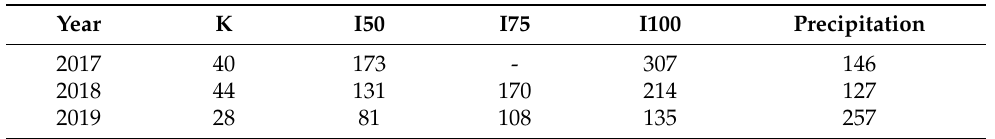
Table 4. Net irrigation water (mm) provided in the different water shortage stress treatments and the natural precipitation (mm) in the three